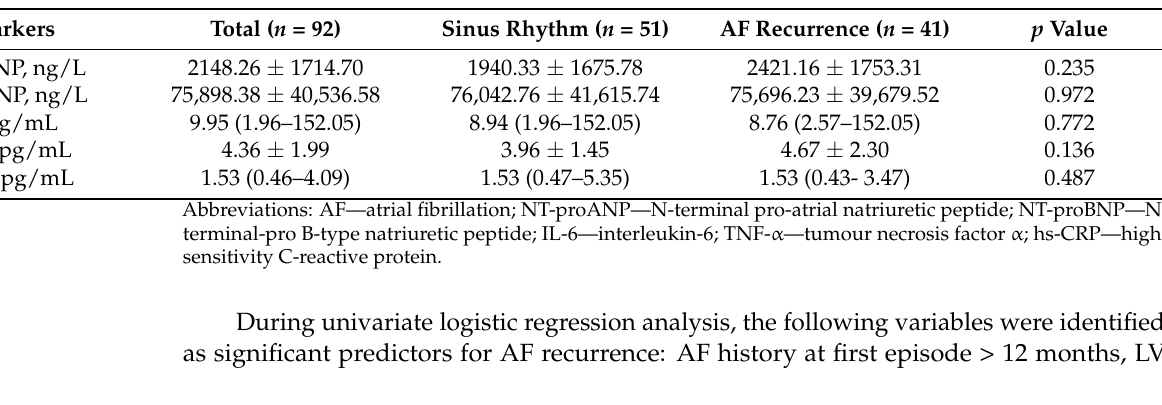
Table 3. Biomarker characteristics of the